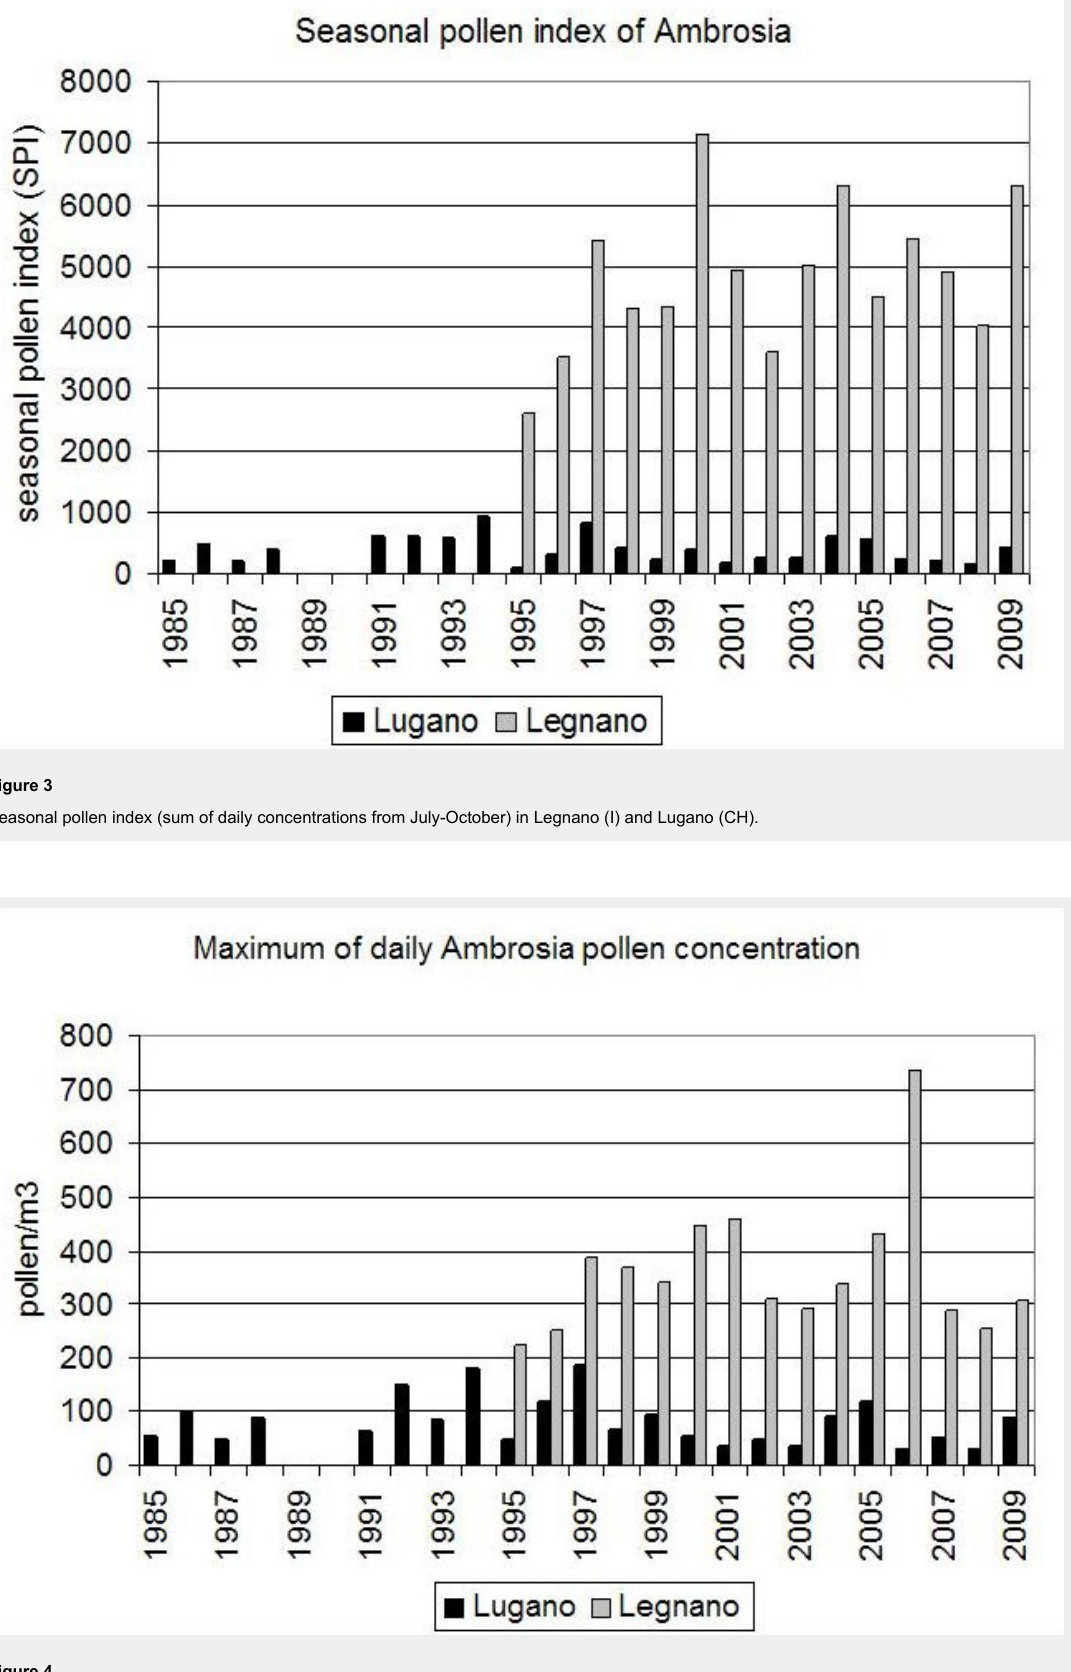
Figure 4 Maximum values of the daily pollen concentration in Legnano and